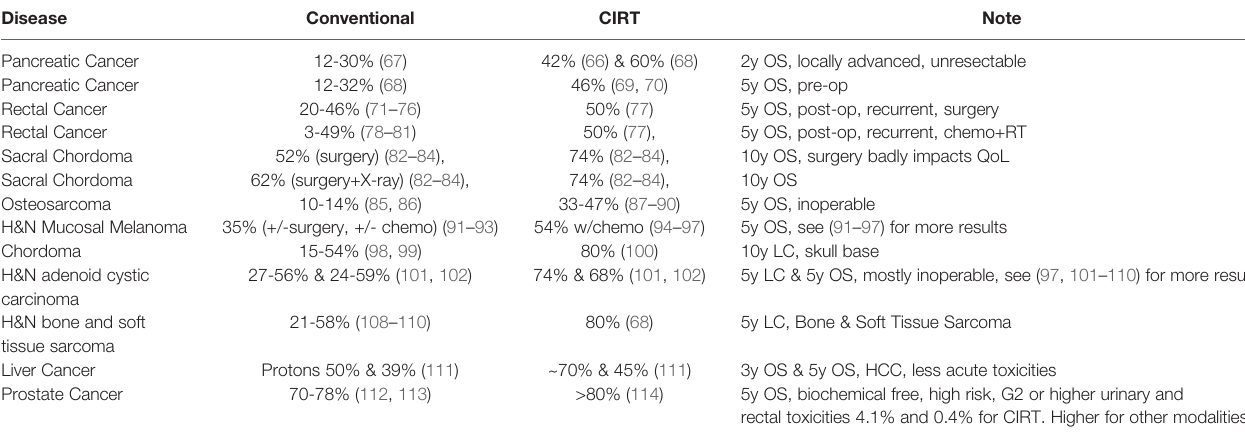
TABLE 1 | Comparison of heavy ion therapy with conventional radiotherapy clinical results – examples indicating the potential bene fi t of heavy ion therapy. Disease